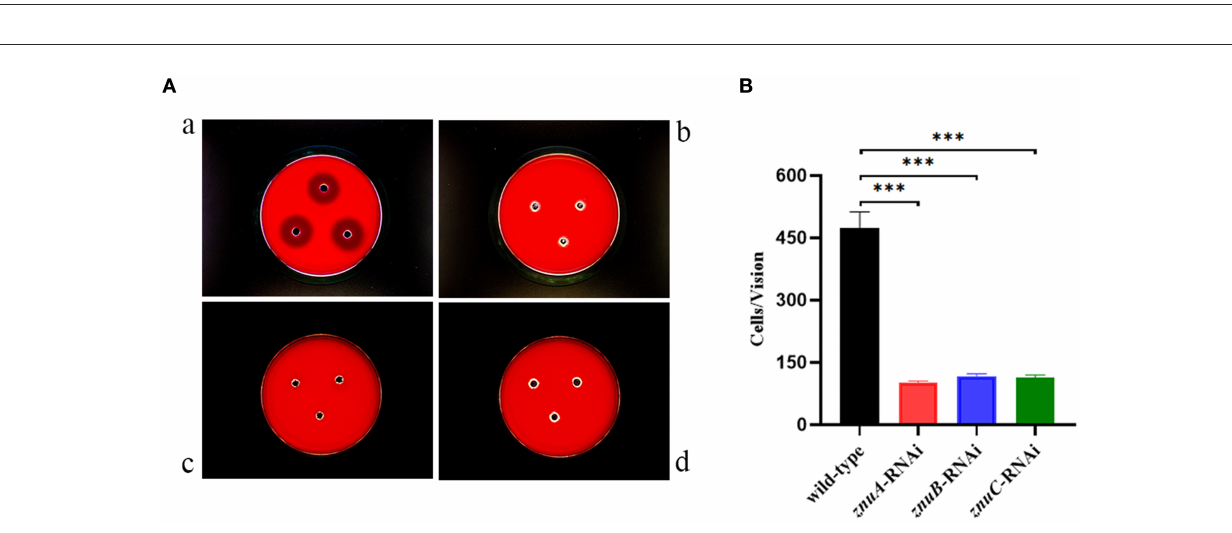
FIGURE6 Determination of hemolytic ability and adhesion ability in vitro of wild-type, znuA -RNAi, znuB -RNAi and znuC -RNAi strains of A. salmonicida SRW-OG1. (A) was the typical observation of the hemolytic assay of wild-type (a), znuA -RNAi (b), znuB -RNAi (c) and znuC -RNAi (d) of A. salmonicida SRW-OG1 under the optical microscope; (B) is the histogram of the number of wild-type, znuA -RNAi, znuB -RNAi and znuC -RNAi strains of A. salmonicida SRW-OG1 in the field of optical microscope during in vitro adhesion test. Data were presented as mean ± standard deviation (SD) ( n = 3). *** P <